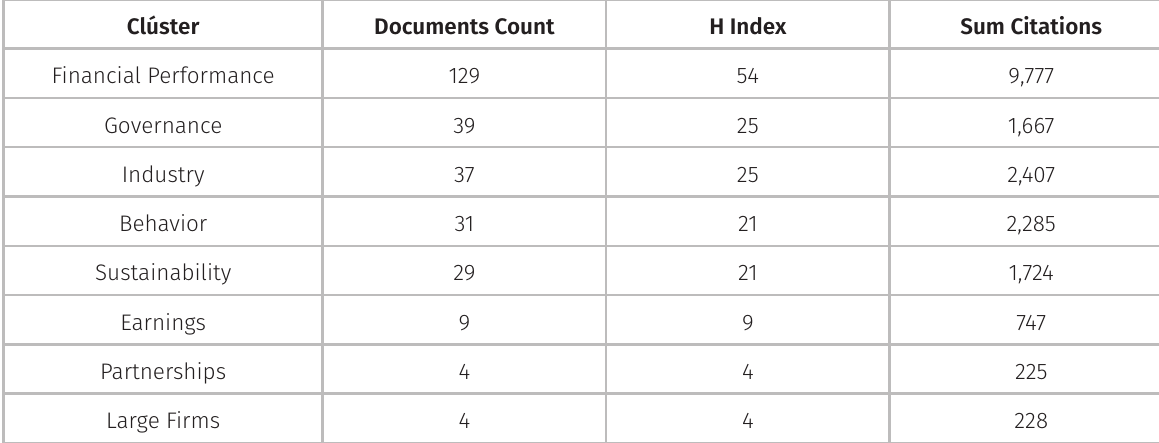
Table VI. Performance of the themes in the 2007–2010